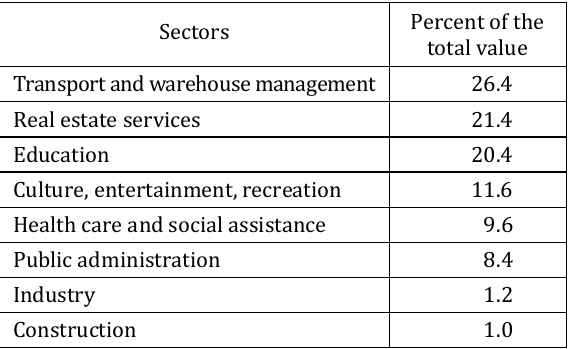
Table 3. Capital expenditure by sectors in Żory in 2009 (after Rocznik statystyczny województwa śląskiego, 1989-2009)